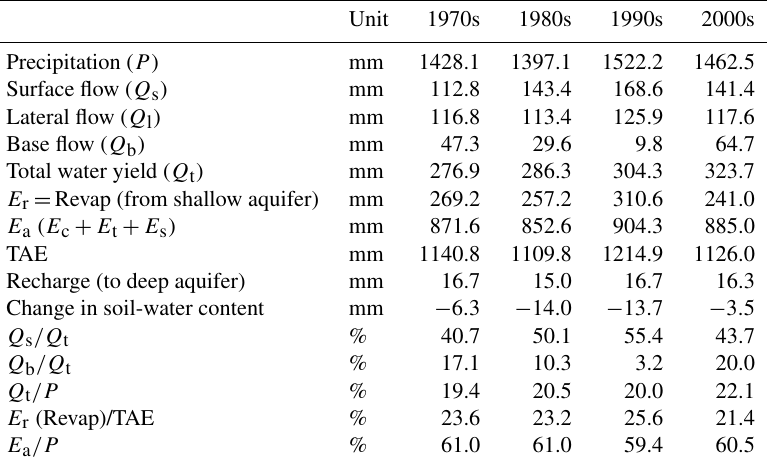
Table 8. Mean annual water-balance-component analysis in the upper Blue Nile River basin, considering LULC and climate change over their respective periods. All streamflow estimates are for the El Diem station, where water yield ( Q t ) = Q s + Q l + Q b and change in soil